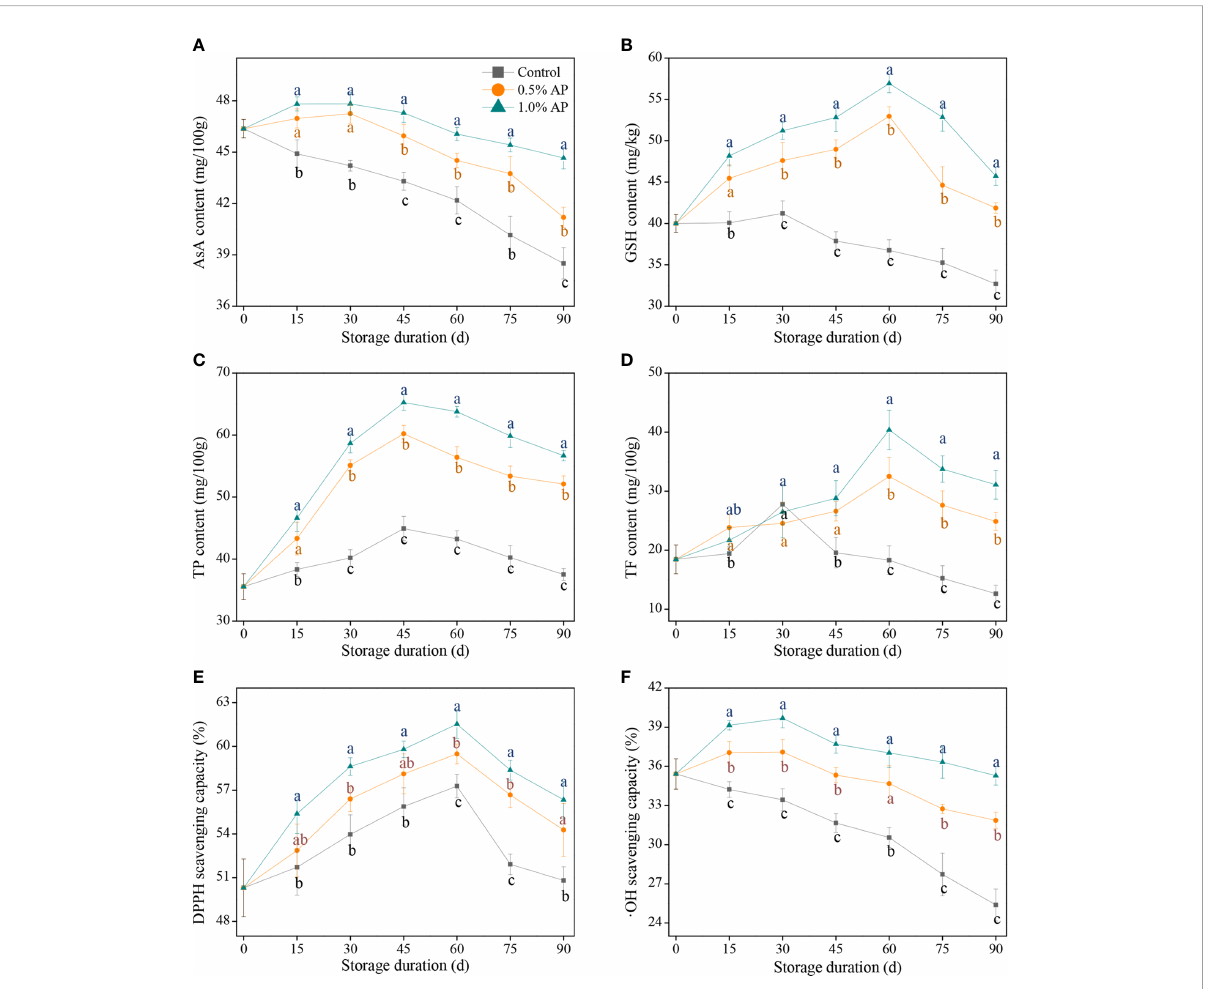
FIGURE 3 Variation in AsA content (A) , GSH content (B) , TP content (C) , TF content (D) , DPPH scavenging capacity (E) , and (cid:129) OH scavenging capacity (F) in the juice sac of ‘ Jinshayou ’ pummelo fruit treated without or with AP (0.5% and 1.0%) during room temperature storage period. The different letters for each same sampling point indicate signi fi cantly different at P < 0.05 according to Duncan ’ s multiple range